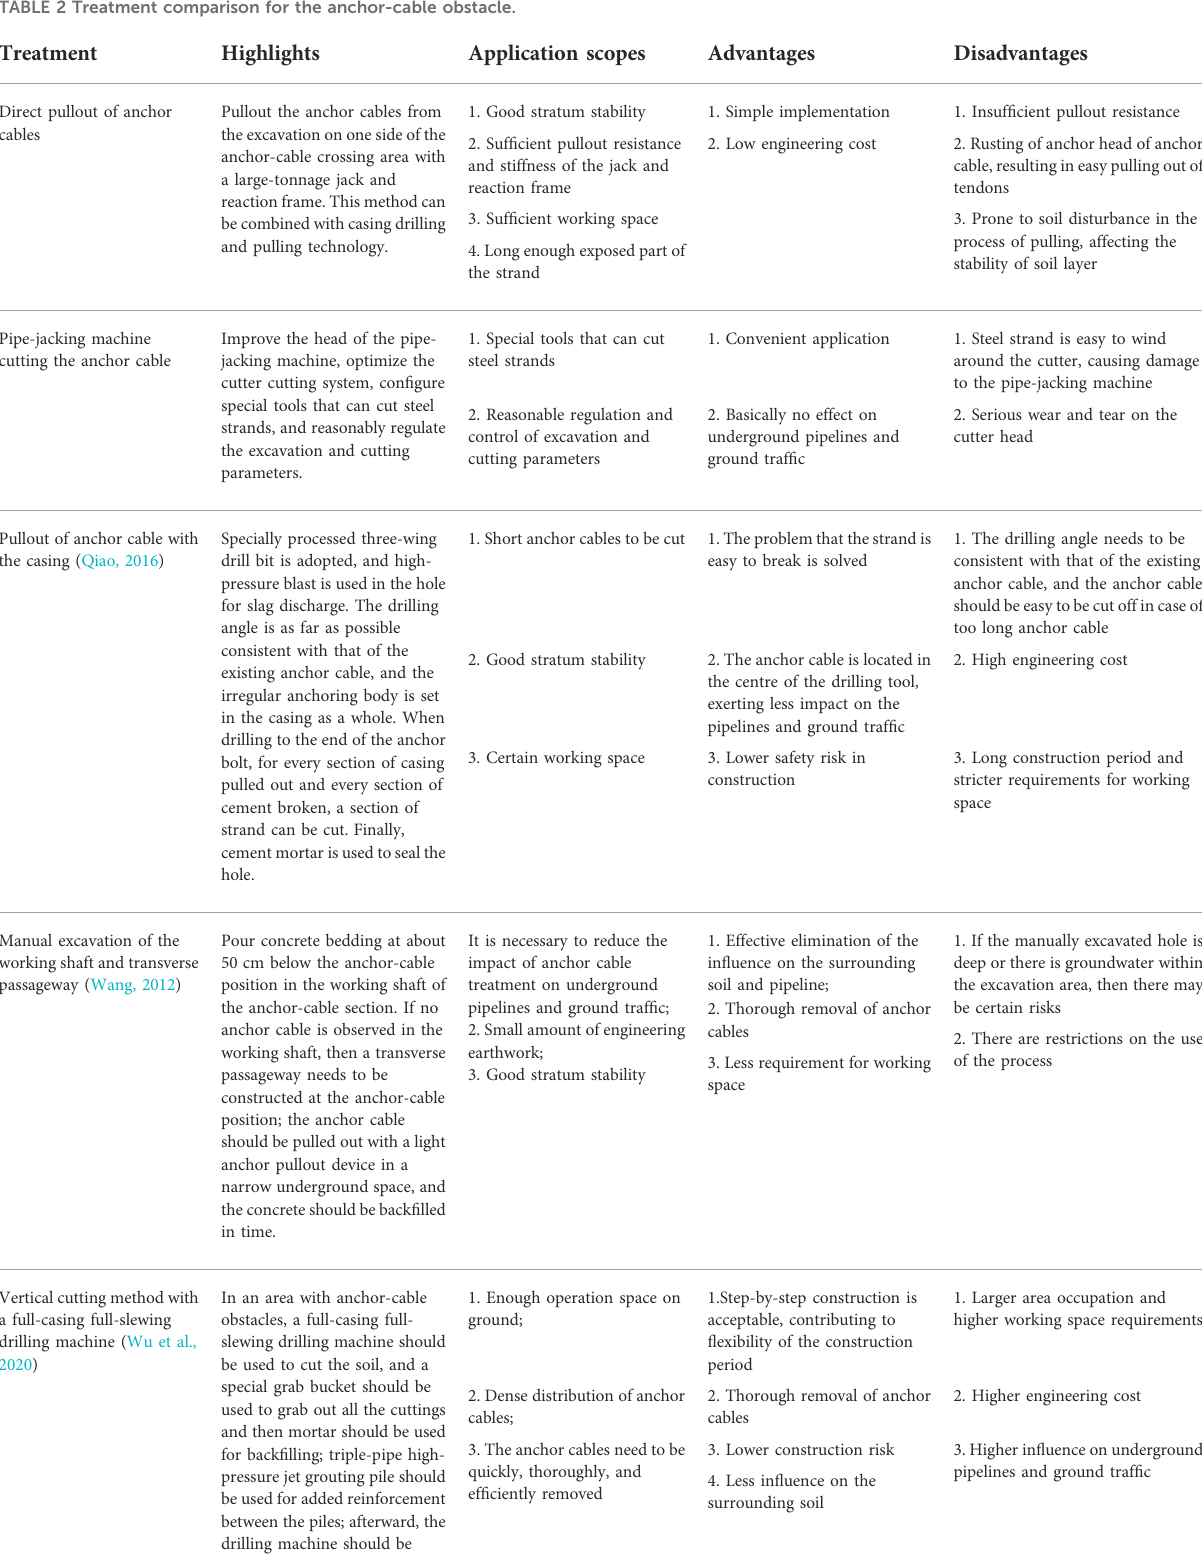
TABLE 2 Treatment comparison for the anchor-cable obstacle.